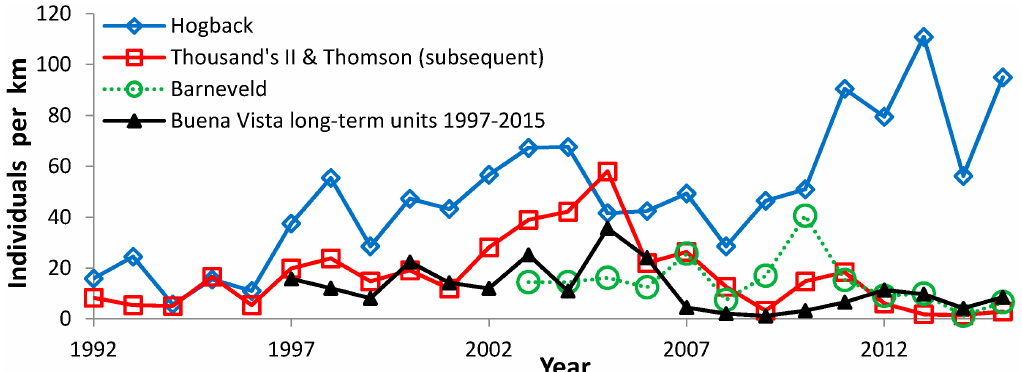
Figure 6. Regal fritillary individuals per km on peak survey per year at Hogback, Thousand’s II/Thomson (subsequent) combined, Barneveld, and Buena Vista (long-term units 1997–2015).